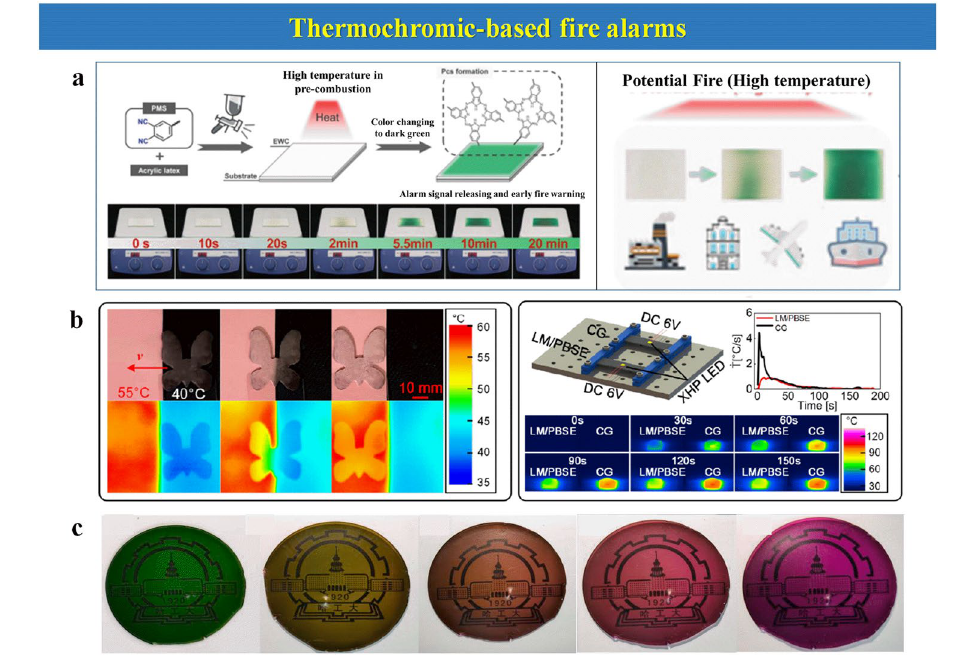
Fig. 9 a The fabrication of EWC, its color change process, and the potential fire simulation experiments at 275 °C and (fire alarm remote moni‑ toring). Reproduced with permission from Ref. [57]. Copyright 2019 Wiley. b The thermal camouflage and thermal dissipation behavior of the LM/PBSE. Reproduced with permission from Ref. [92]. Copyright 2022 American Chemistry Society. c The color changes of the PMF material at different temperatures. Reproduced with permission from Ref. [93]. Copyright 2022